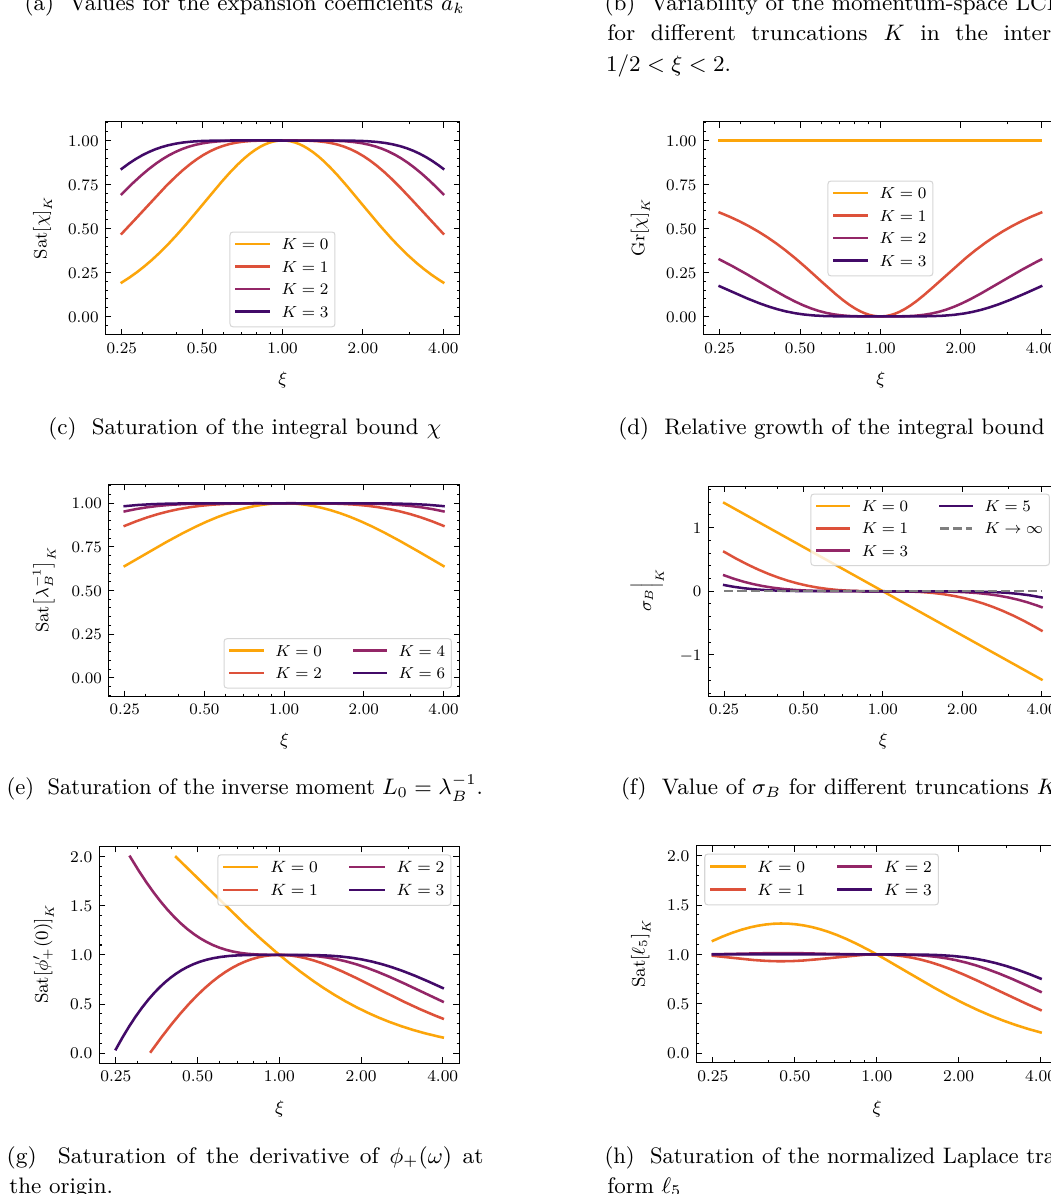
Figure 2 . Plots illustrating the truncation effects of our parametrization for the exponential model eq. (4.9). We often use the ratio ξ = ω , plotted on a logarithmic 0 /λ B